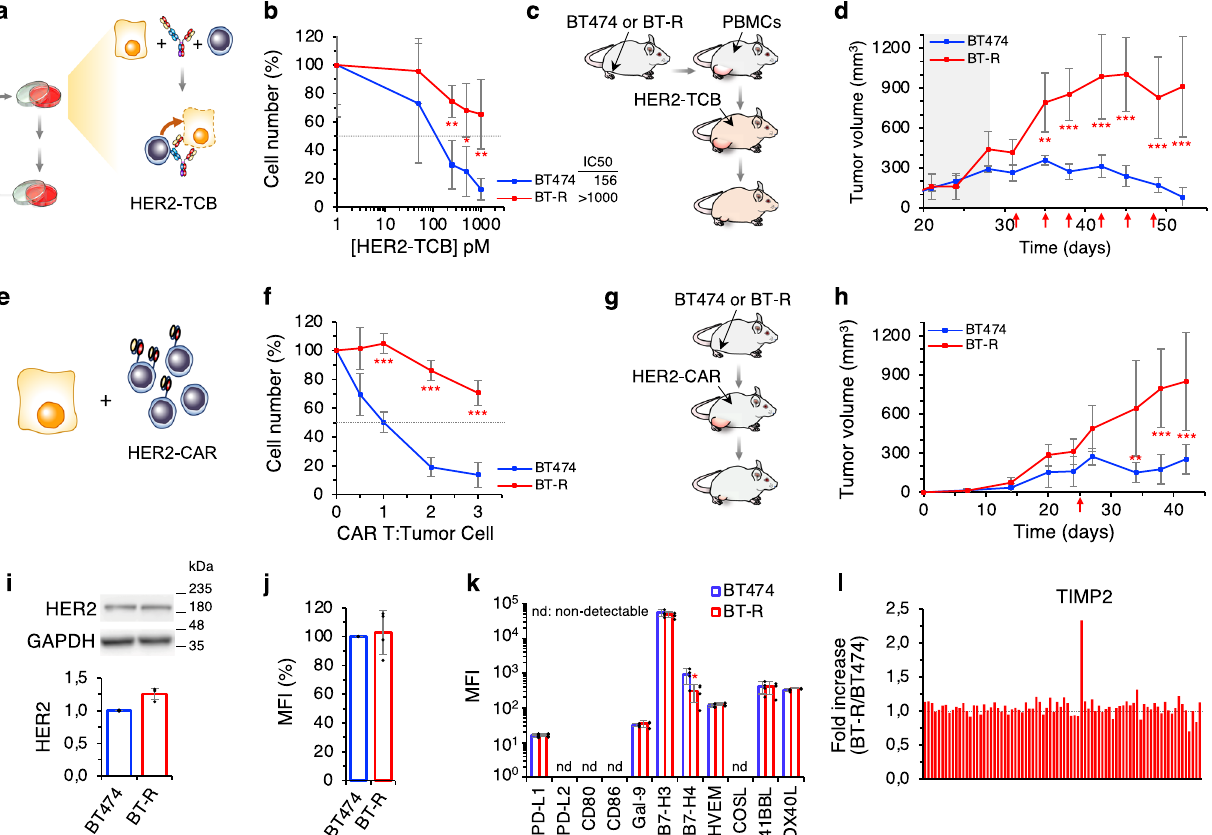
Fig. 1 Generation and characterization of resistant cells. a Schematic showing the assay of HER2-TCB in cocultures. b Cocultures of PBMCs with parental BT474 or resistant BT-R cells were treated with different concentrations of HER2-TCB (PBMC:target cell ratio 1:1) for 72 h. Then, viable cells were quanti fi ed by fl ow cytometry using EpCAM as a marker. c Schematic showing in vivo treatment with HER2-TCB. Totally, 10 7 BT474 or BT-R cells were injected orthotopically into NSG mice. When tumors reached ~200 mm 3 (dark background), 10 7 PBMCs were injected i.p. Then animals were treated i.v. with 0.125 mg/kg HER2-TCB as indicated (red arrows). d Tumor volumes are represented as averages ± SD (standard deviation) ( n = 4 per arm). e Schematic showing the HER2-CAR assay. f Parental BT474 cells or resistant BT-R cells were cocultured with different ratios of CAR T cells for 48 h. Cell numbers were calculated and expressed as in ( b ). g Schematic showing in vivo treatment with HER2-CAR T cells. Mice were injected with BT474 or BT-R cells as in ( c ). When tumors reached ~200 mm 3 , 3 × 10 6 HER2-CAR T-positive cells were injected i.p. h Tumor volumes are represented as averages ± SD (BT474, n = 6; BT-R, n = 8). i Levels of HER2, normalized to BT474 cells, were determined by Western Blot. j Cells were stained with HER2-TCB and analyzed by fl ow cytometry. Results were normalized to BT474 cells. k Cells were stained with antibodies against the indicated factors. Results are presented as the MFI of staining in BT474 and BT-R cells. l , Levels of 80 cytokines and growth factors were measured using a commercial array in the media conditioned by cocultures of BT474 cells and PBMCs or BT-R cells and PBMCs treated with HER2-TCB. Results are presented as the fold change of BT-R relative to BT474 cells. b ** p = 0.005, * p = 0.02, ** p = 0.006. f *** p < 0.001. k * p = 0.04, two-tailed t test. d , h ** p < 0.01, *** p < 0.001, two-way analysis of variance (ANOVA) and Bonferroni correction. Data are presented as mean ± SD of four ( b , f , j , k ), or three ( i ) independent experiments. Source data are provided as a Source Data fi